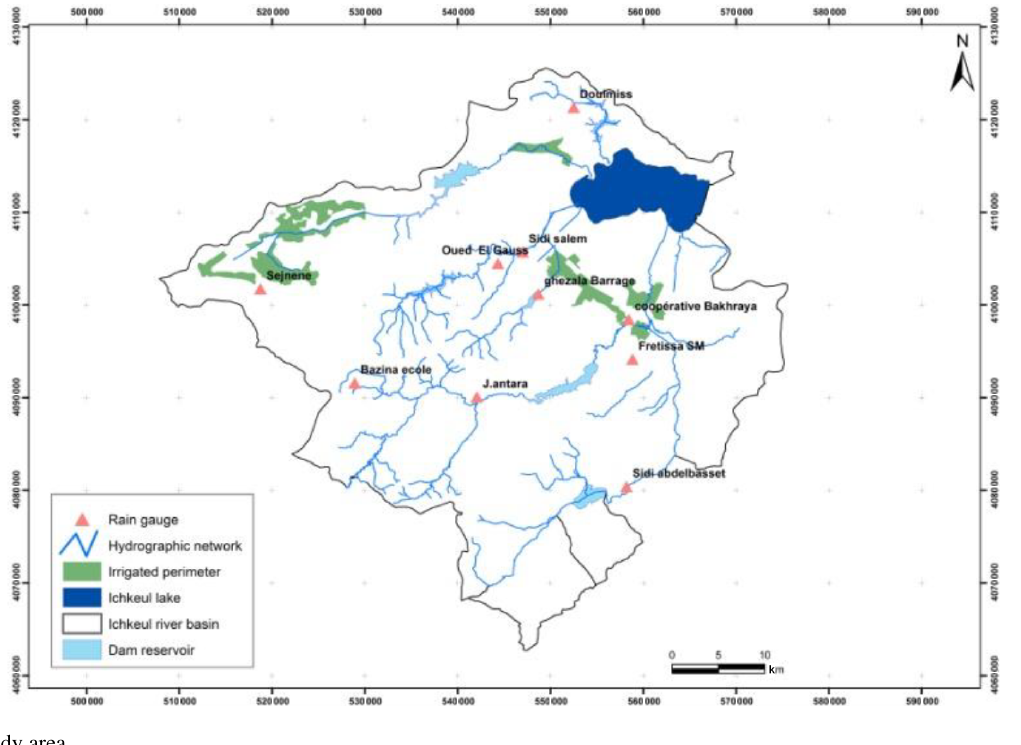
Figure 1. Study area.